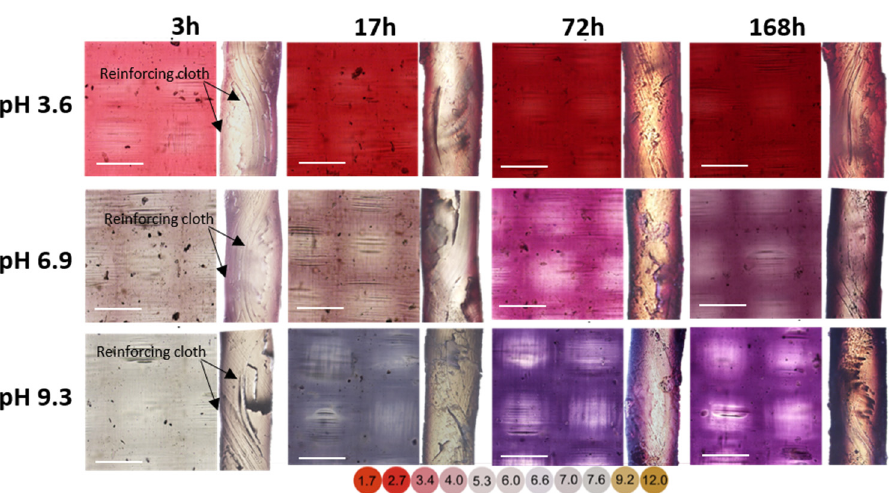
Figure 8. Optical images of the surface (left) and cross-sections (right) of CSE-fg membrane coupons that were in contact with cranberry juice for 3, 17, 72, and 168 h. Before obtaining images, these coupons were placed for 2 h in a buffer solution at pH 3.6, 6.9, and 9.3. The dependence of cranberry juice pH (diluted 10 times) on its color is shown below the figure. The scale is 300 µm for membrane surface and 150 µm for cross-section.